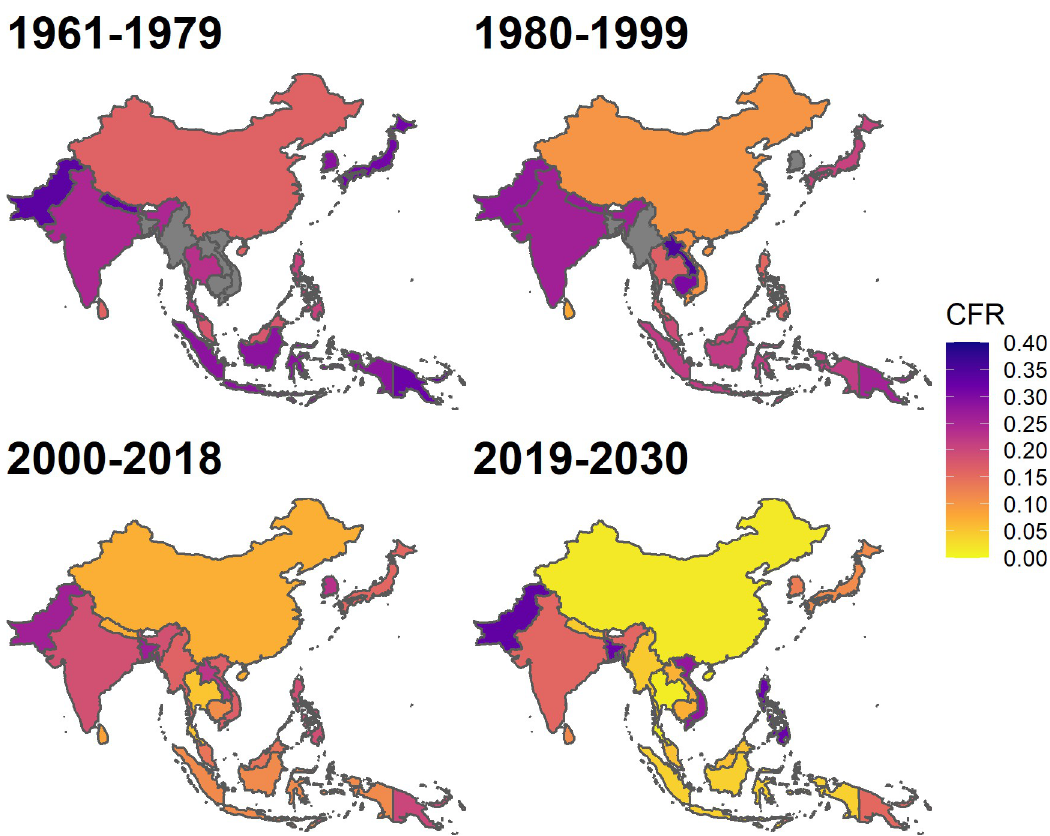
Fig 4. Spatial and temporal distribution of Japanese encephalitis (JE) National case-fatality ratio (CFR) estimates in JE (endemic countries) from 1961–2030. Countries without estimates were filled with grey (values for these estimates are given in Table 4). The underlying map was generated using open source data from